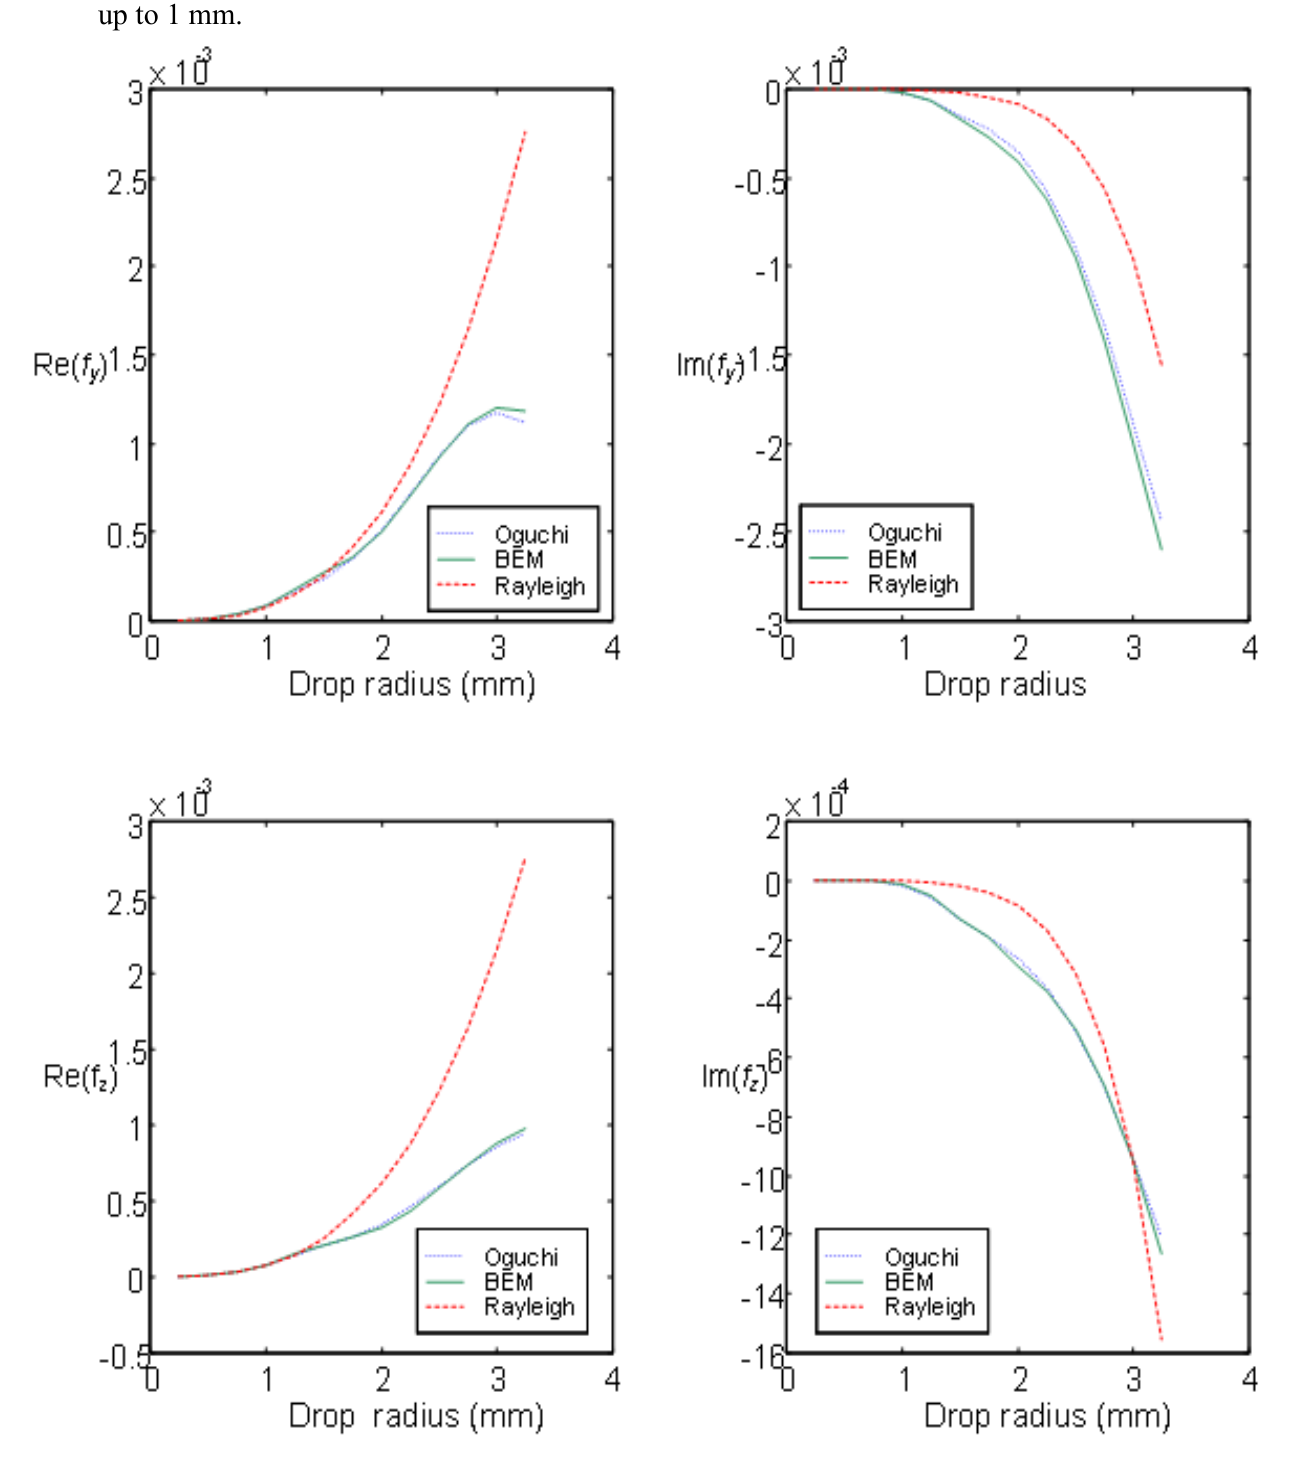
Figure 5. Real and imaginary parts of the amplitude scattering functions vs. raindrop radii at 13 GHz. Direction of propagation of the incident wave: ˆ x , horizontal ( ˆ y ) and vertical polarizations ( ˆ z ). BEM solution (solid line) agrees well with Oguchi [15] (dotted line) for raindrops up to 3.25 mm radius. Rayleigh solution (dashed line) agrees with BEM solution up to 1